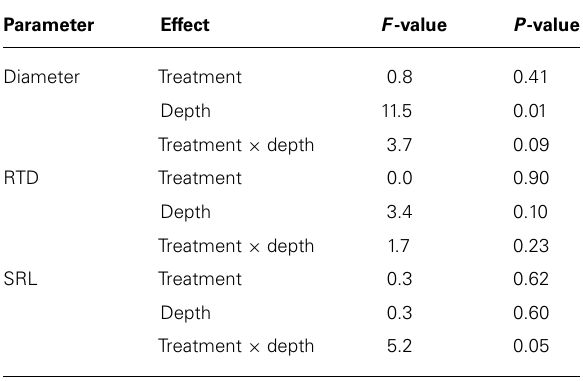
Table 6 | Results of split-plotANOVA examined for effects of the N fertilization (treatment) and soil depth (depth) on diameter, root